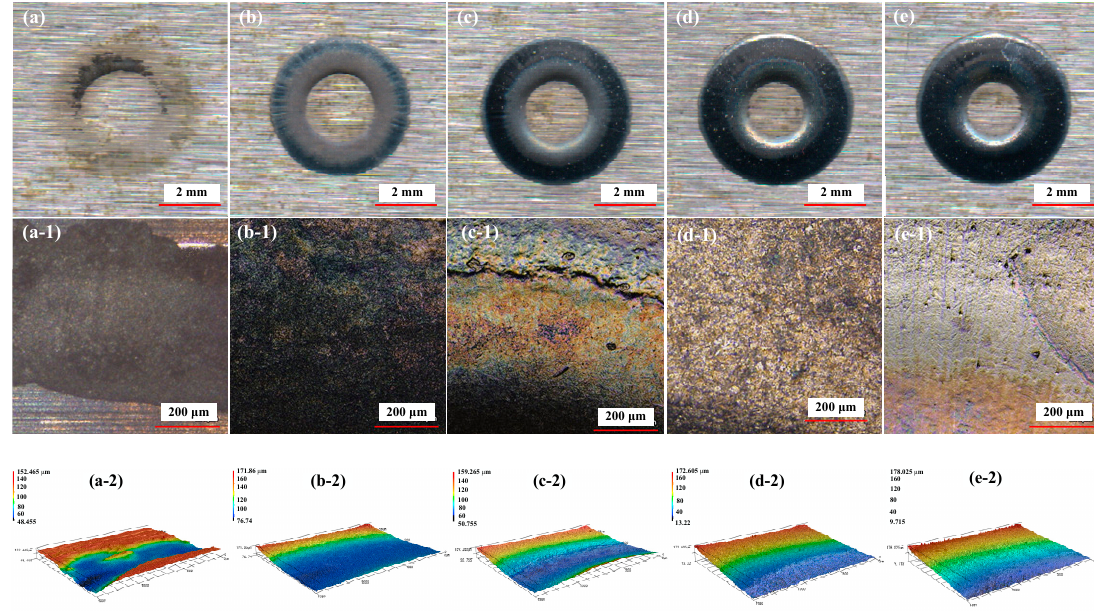
Figure 12. Surface morphology of workpiece at different current density in NaClO 3 electrolyte: ( a ) 200 g/L, 10 A/cm 2 ; ( b ) 200 g/L, 20 A/cm 2 ; ( c ) 200 g/L, 30 A/cm 2 ; ( d ) 200 g/L, 40 A/cm 2 ; ( e ) 200 g/L, 50 A/cm 2 . Micromorphology of workpiece local surface: ( a-1 ) 200 g/L, 10 A/cm 2 ; ( b-1 ) 200 g/L, 20 A/cm 2 ; ( c-1 ) 200 g/L, 30 A/cm 2 ; ( d-1 ) 200 g/L, 40 A/cm 2 ; ( e-1 ) 200 g/L, 50 A/cm 2 . 3D profile of workpiece local surface: ( a-2 ) 200 g/L, 10 A/cm 2 ; ( b-2 ) 200 g/L, 20 A/cm 2 ; ( c-2 ) 200 g/L, 30 A/cm 2 ; ( d-2 ) 200 g/L, 40 A/cm 2 ; ( e-2 ) 200 g/L, 50 A/cm 2 .